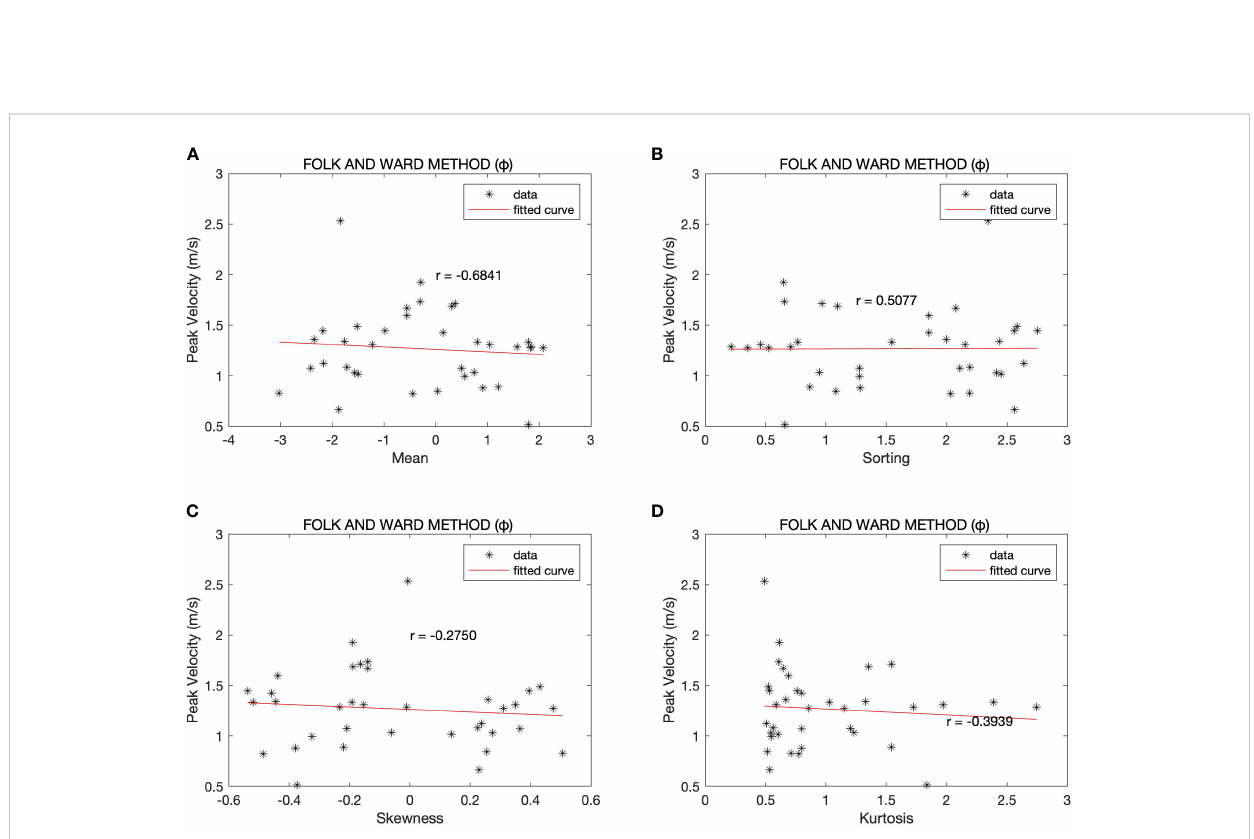
FIGURE 10 Correlation between Peak Velocity and sediment properties: (A) Mean, (B) Sorting, (C) Skewness, (D)